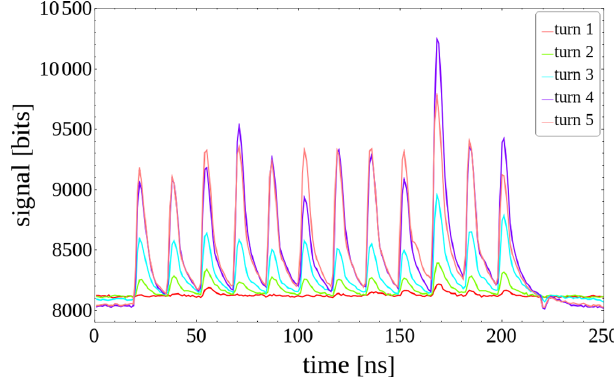
FIG. 11. The measured waveform of the 12 bunch train on a few turns surrounding the peak of the signal.